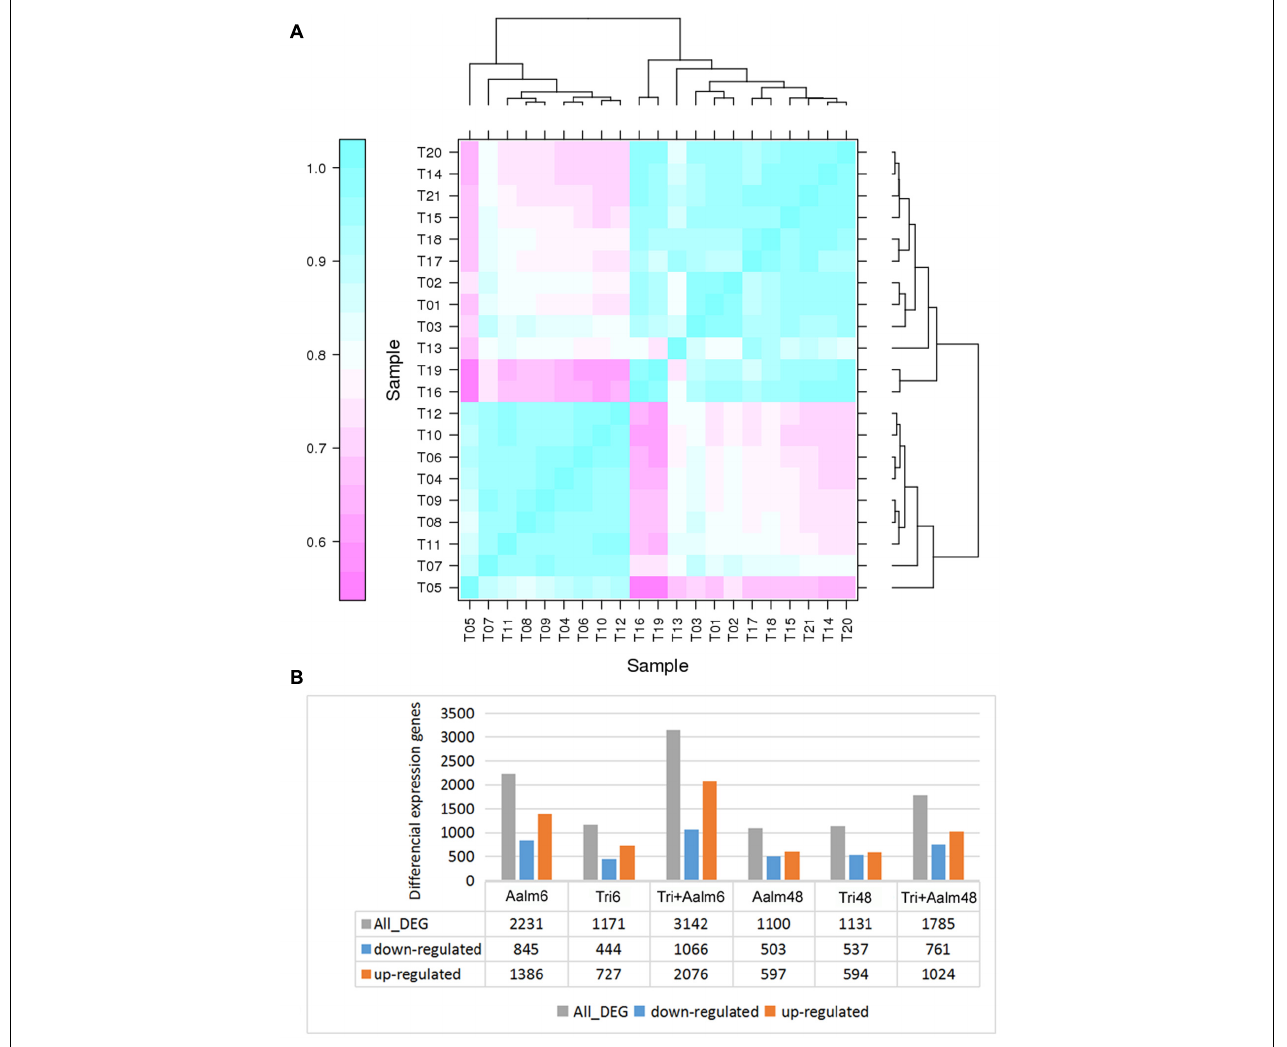
FIGURE 1 | The differential expression genes of Malus sieversii treated with Trichoderma biofertilizer and Aalm. (A) The correlation analysis of gene expression pattern. T1-3 (Con): the control; T4-6 (Aalm6): M. sieversii treated with A. alternata f. sp. mali for 6 h; T7-9 (Tri6): M. sieversii treated with Trichoderma biofertilizer for 6 h; T10-12 (Tri + Aalm6): M. sieversii treated with Trichoderma biofertilizer and A. alternata f. sp. mali for 6 h. T13-15 (Aalm48): M. sieversii treated with A. alternata f. sp. mali for 48 h; T16-18 (Tri48): M. sieversii treated with Trichoderma biofertilizer for 48 h; and T19-21 (Tri + Aalm48): M. sieversii treated with Trichoderma biofertilizer and A. alternata f. sp. mali for 48 h. (B) The number of differential expression